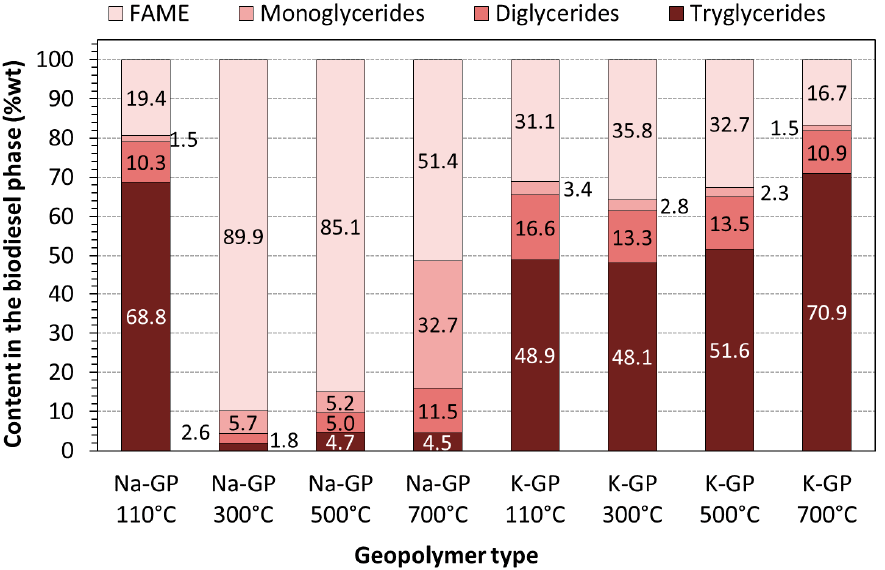
Figure 5. FAME and glycerides contents in biodiesel phase obtained with sodium and potassium geopolymer powders treated at different temperatures.